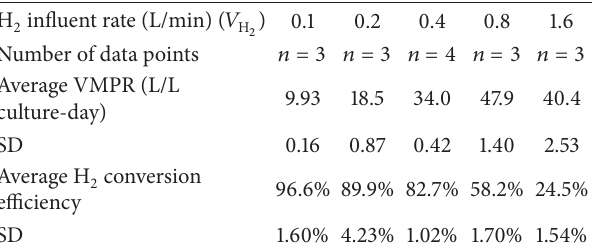
Table 2: Average volumetric methane production rates and hydro- gen conversion efficiencies for Experiment 1. Averages were taken for experimental values in Figure 2 at each hydrogen influent rate from 3 or 4 days. Standard deviations (SD) were calculated based on the values used to calculate the